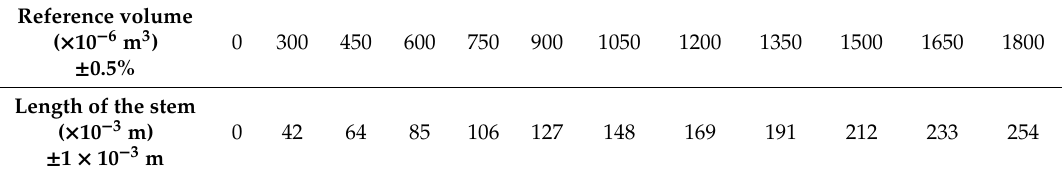
Table 1. The relationship between the length of stem and volume provided by the